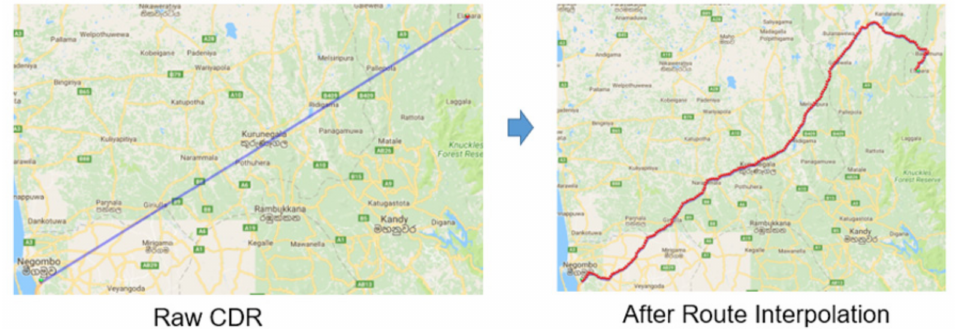
Figure 6. An example of a trip estimation based on raw CDR data and after conducting route interpo- lation.